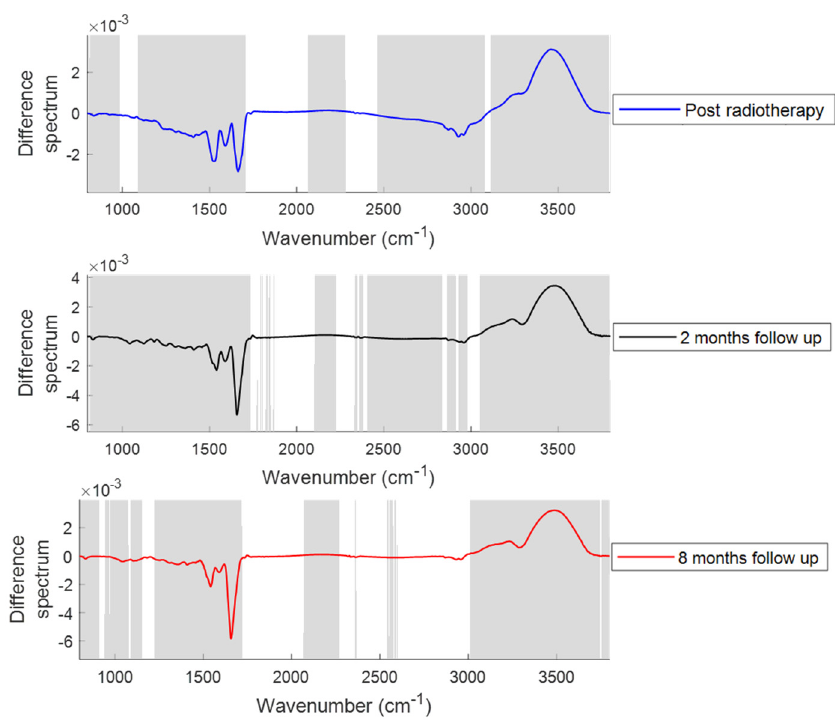
Figure 3. Di ff erence spectra of plasma from patients post radiotherapy, at two months follow up and at eight months follow up. Di ff erence spectra were computed by subtracting the mean spectra of plasma from the patients at post radiotherapy time points from their mean spectra post hormone treatment. The shaded regions depict the spectral regions which are significantly di ff erent between each sample set using a two-tailed t -test with p < 0.001.